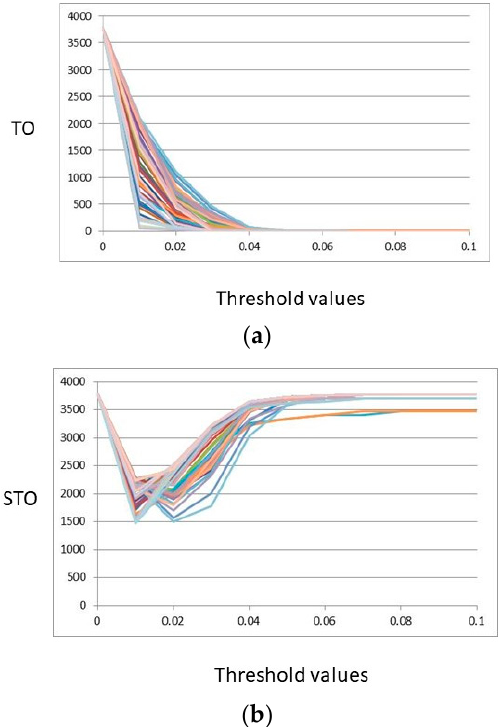
Figure 6. The TO ( a ) and STO ( b ) profile of nodes in the Gulf of Naples food web for different thresholds ( T = 0.01, 0.02, 0.03, 0.04, 0.05, 0.06, 0.07, 0.08, 0.09, 0.1). Every node is represented by a colorful curve. Note that for T = 0 we see the maximal value of the indices.